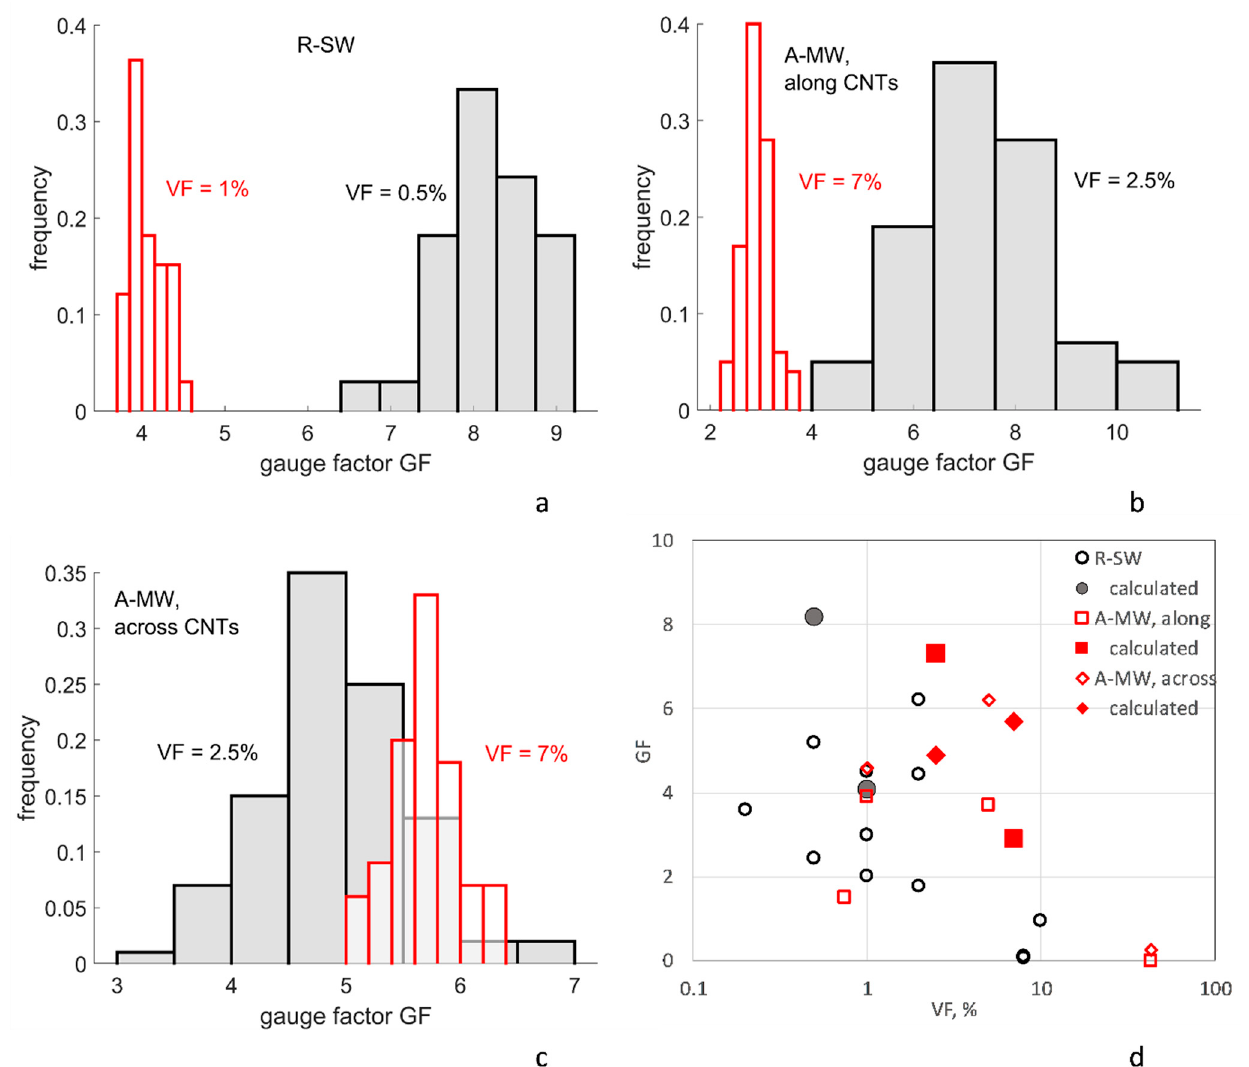
Figure 9. The gauge factors, Equation (5), ε = 0.01, histograms of the distributions: ( a ) R-SW, VF = 0.5% and 1%; ( b , c ) A-MW, along ( b ) and across ( c ) CNTs, VF = 2.5% and 7%; ( d ) experimental data [65,74,75] , open symbols, in comparison with the computed values (closed symbols). The reference point of the experimental plan: g intr = 10 4 S/m; Δ E 1 = 3 eV; s min = 0.34 nm. Sampling size ≥ 99 for all cases.